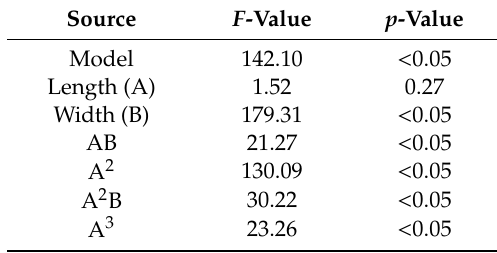
Table 5. ANOVA of response surface reduced cubic model.